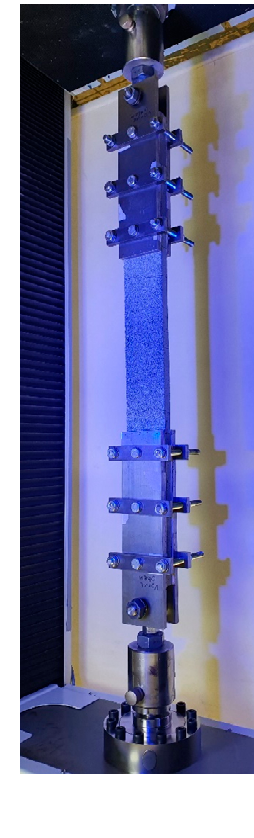
[drawing: L. Manko]